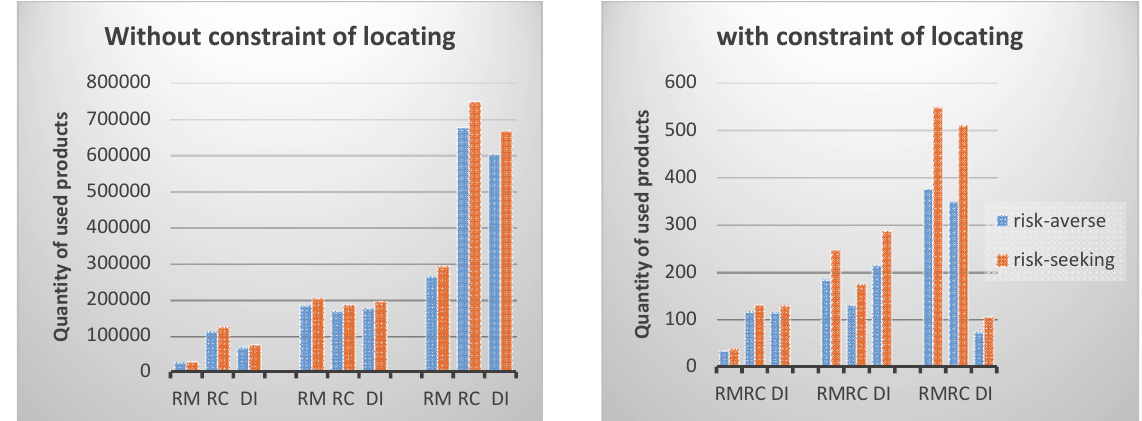
Fig 3 . Comparison the quantity of used products shipped to different centers for being recovery, from the